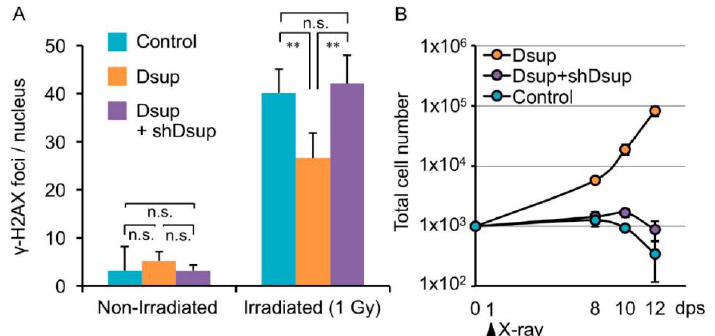
Figure 4. Effects of expression of the tardigrade gene Dsup in human cells (HEK293) on DNA strand breaks ( A ) and cell viability ( B ) after irradiation with X-ray. The figures show the results for non-transfected cells (Control), transfected cells expressing the gene (Dsup), and transfected cells where the gene was not expressed (Dsup+shDsup) ( A ). Estimates of DNA strand breaks using the marker γ -H2AX of non-irradiated and X-ray irradiated (1 Gy) cells. ( B ). Growth patterns of cells of the three treatment groups up to 12 days post-seeding (dps) after X-ray irradiation (4 Gy). Reprinted from